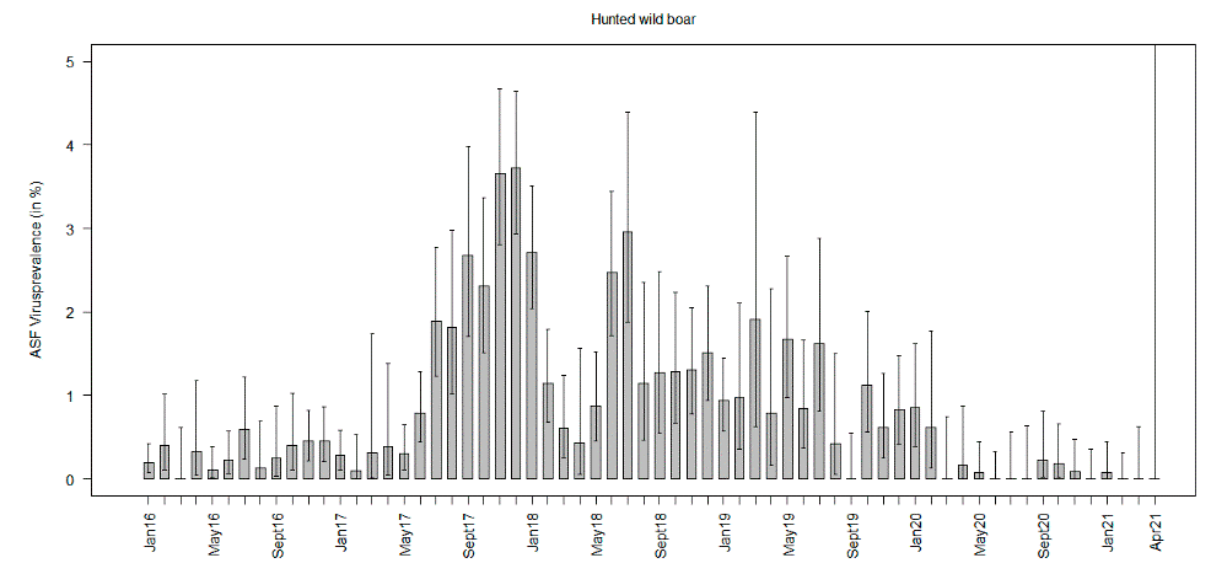
Figure 3. African swine fever virus prevalence estimates per month in hunted wild boar between January 2016 and